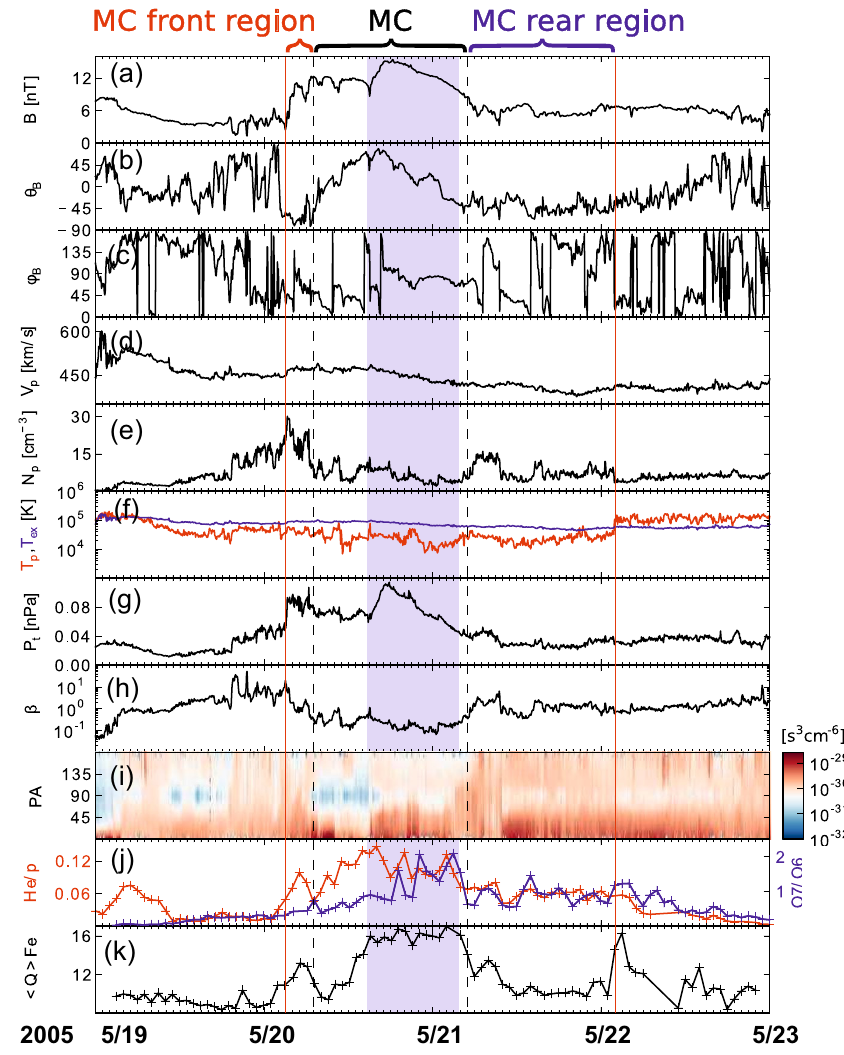
Fig. 7 Different regions of the ICME. The panels show the magnetic field a magnitude, b latitude, and c longitude, d solar wind speed, e density f temperature (black: measured, red: expected temperature), g total pressure perpendicular to the magnetic field, h plasma beta, i pitch angle spectrogram of 272-eV electrons, j red: helium to proton ratio, black: O + 7 /O + 6 ratio, and k average iron charge state. The data are from the ACE spacecraft. Images reproduced by permission from Kilpua et al. (2013b), copyright by the authors